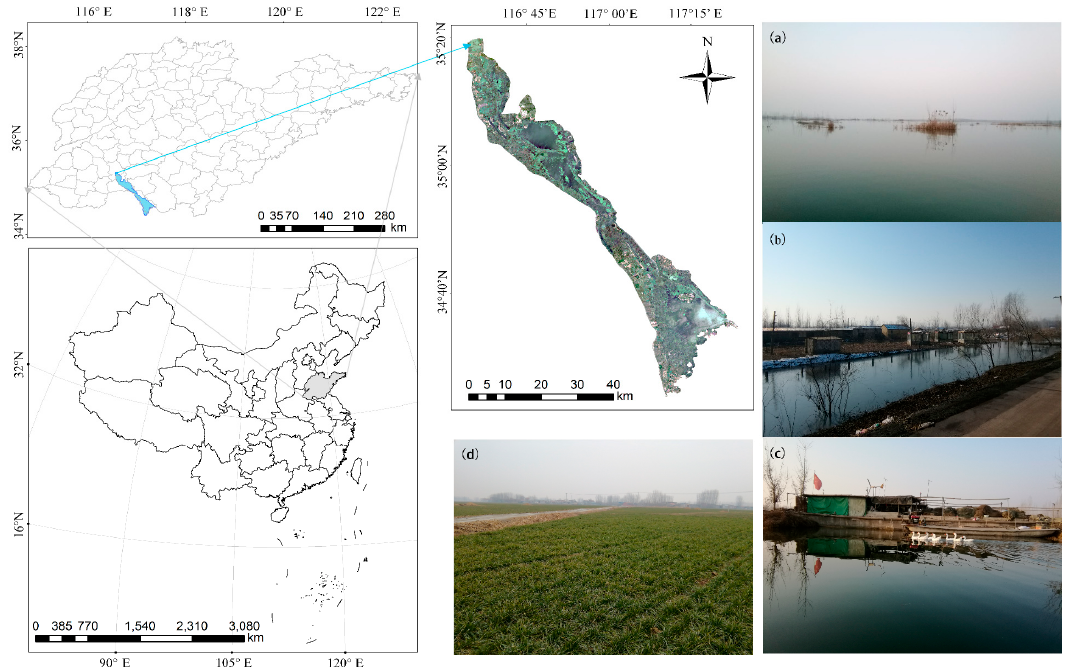
Figure 1. Location of the study area and landscape photos in the Nansi Lake Wetland. ( a ) Lakes; ( b ) Rivers; ( c ) Ponds; ( d ) Paddy fields.